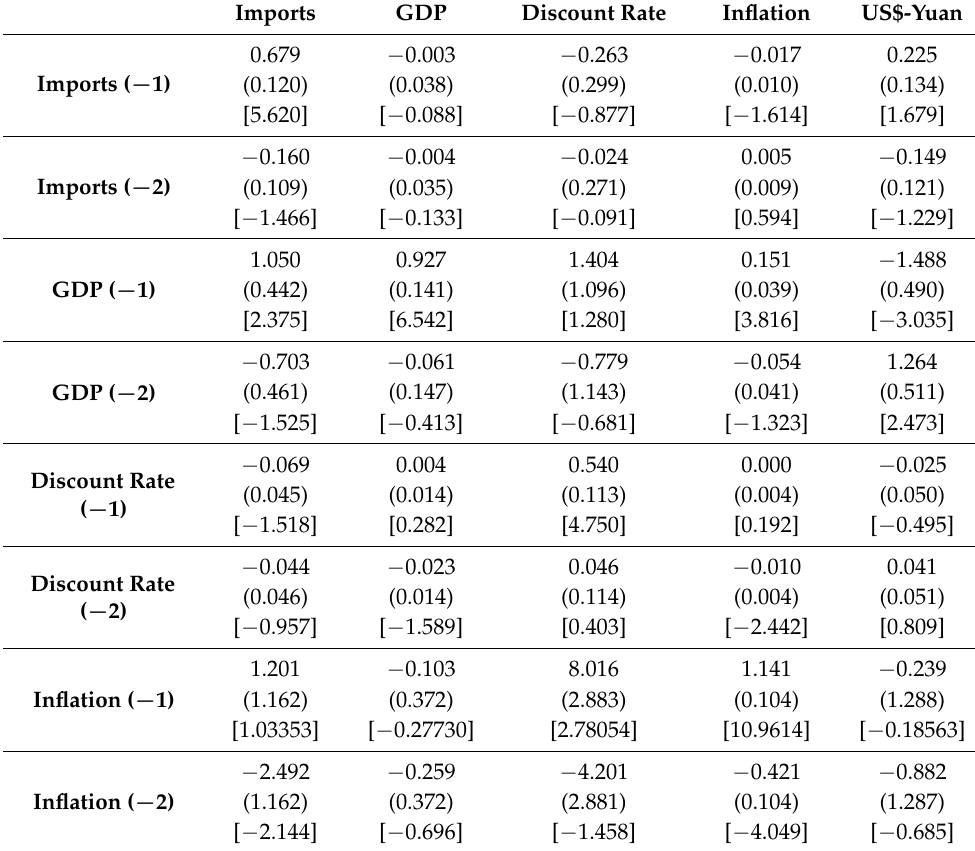
Table 3. Vector Autoregression Model Estimations, China, 2000–2020.